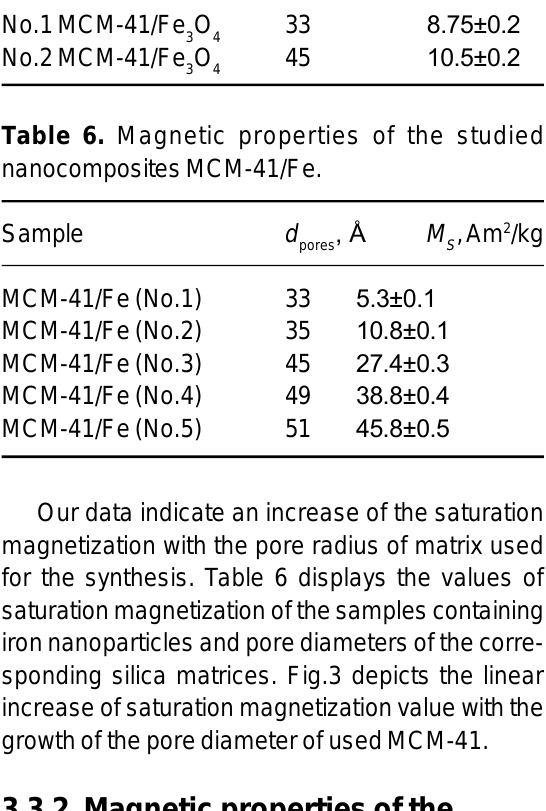
Table 7. Magnetic properties of MCM-41/Fe